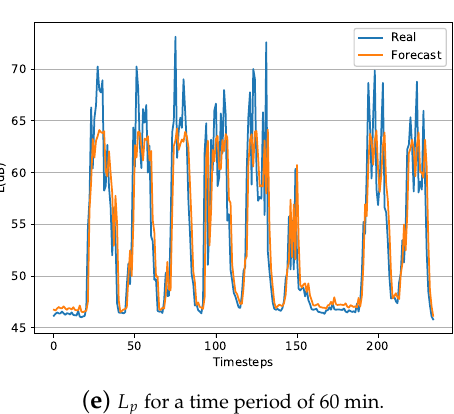
Figure 2. Representation of captured and estimated LSTM data during approximately ten days test-interval (20% of the data) of L p